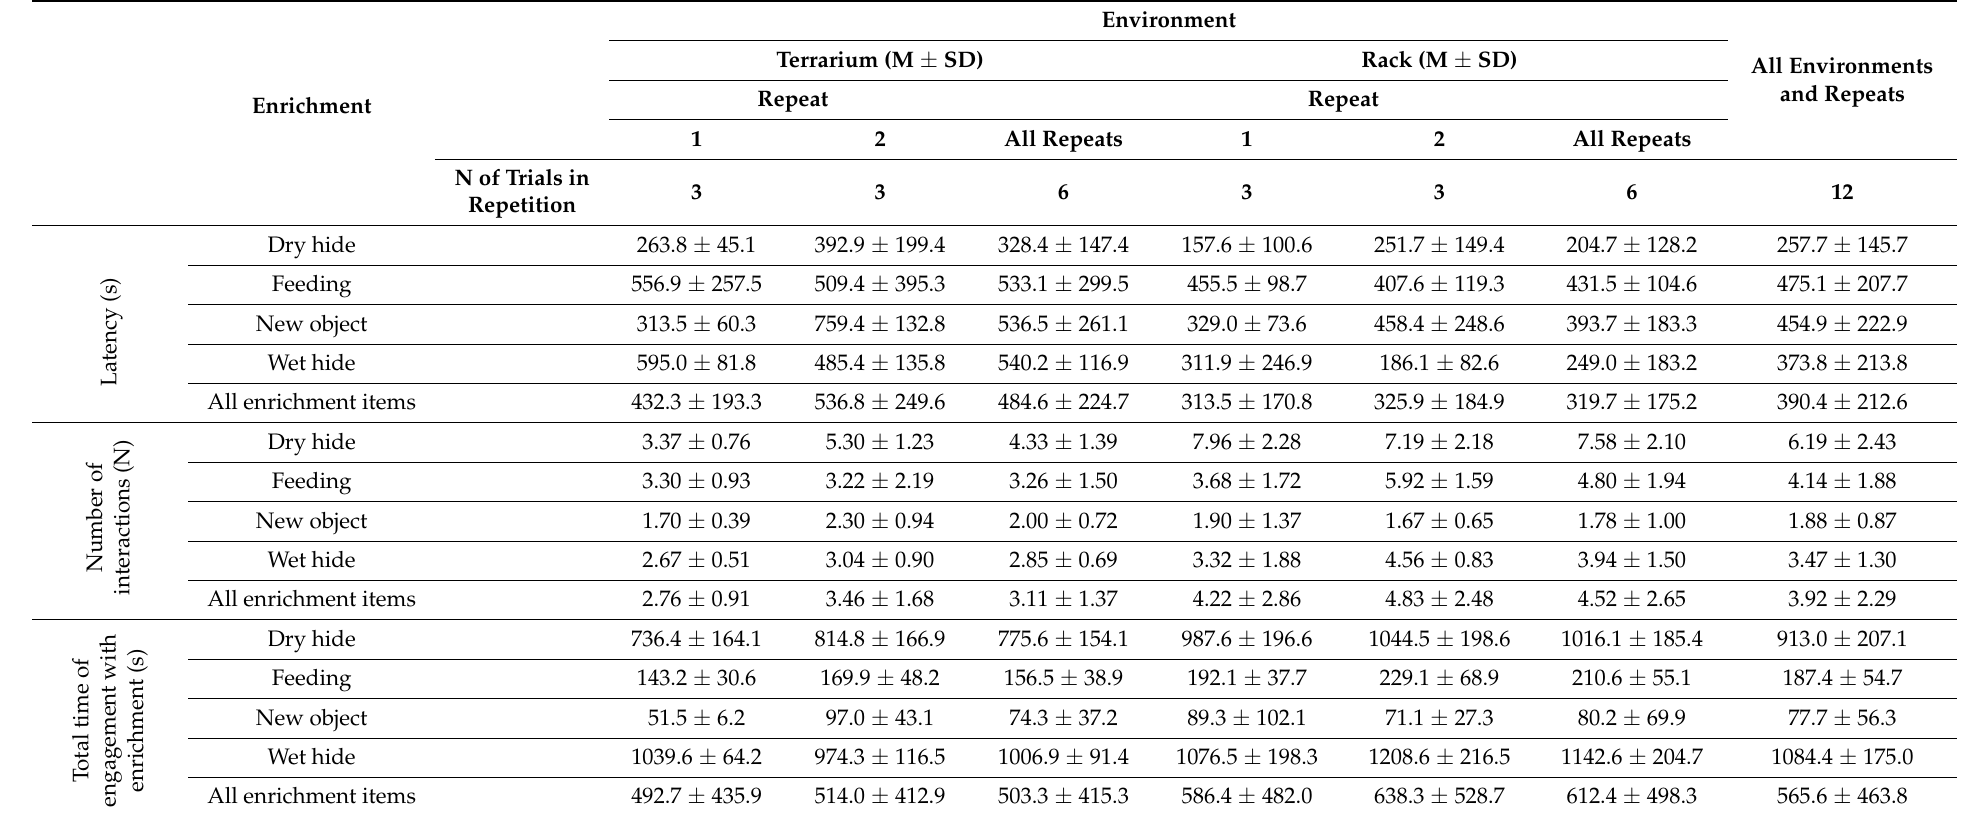
Table 1. Latency (s), number of interactions (N), and total time of engagement with enrichment (s) depending on environment and enrichment in both repetitions. M, mean; SD, standard